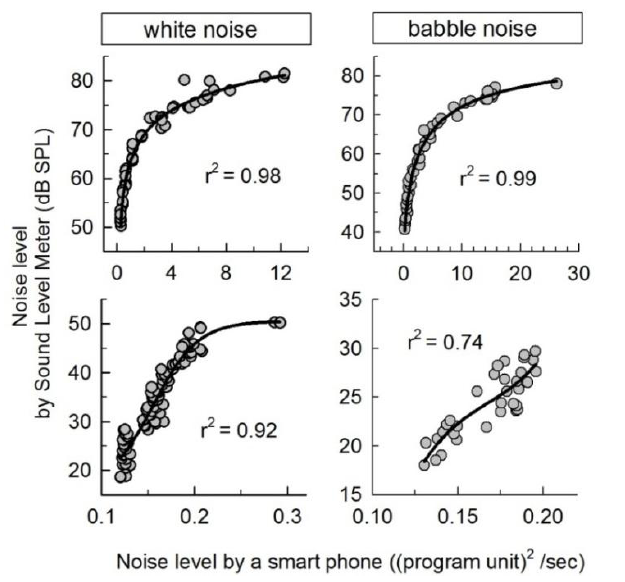
Figure 3. The noise-level relationships measured by a smartphone and a sound-level meter. White noise (left) and babble noise (right) were presented using two loud speakers. Circles represent data by repeated measures. Lines show the interpolated data using a discrete set of measured